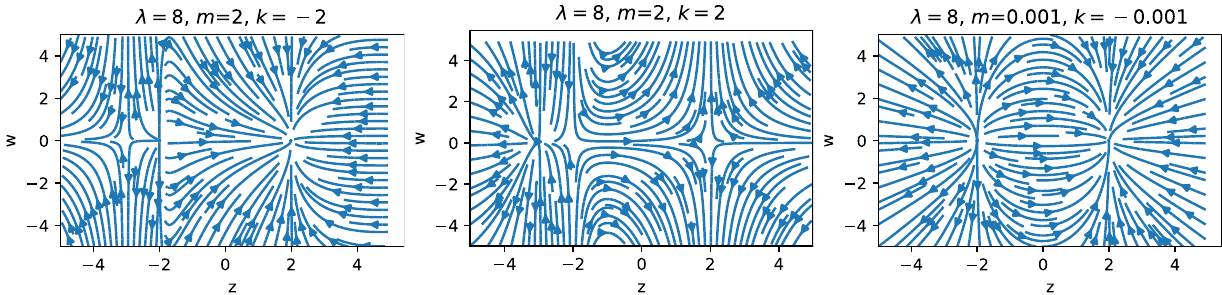
Fig. 3 Different views of the phase space of the dynamical system in Eq. (79). The system was reduced to a 2-d surface representing different perspectives. The arrows represent the direction of the velocity field and the trajectories reveal their stability properties as described for this